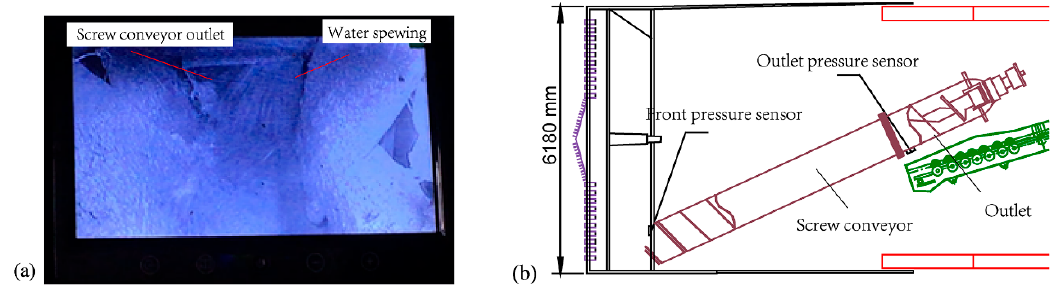
Figure 9. Water spewing from the screw conveyor. ( a ) The water spewing at ring 198th, and ( b ) the pressure sensor position.